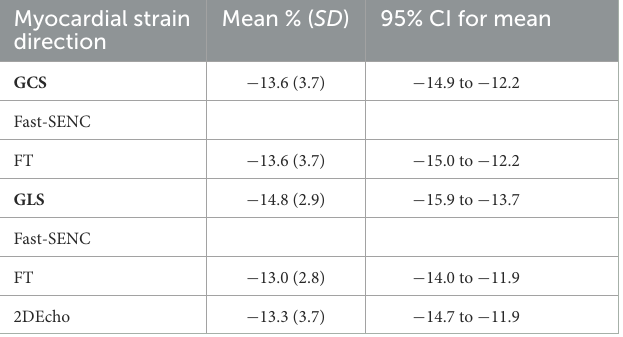
TABLE 2 Global circumferential and longitudinal